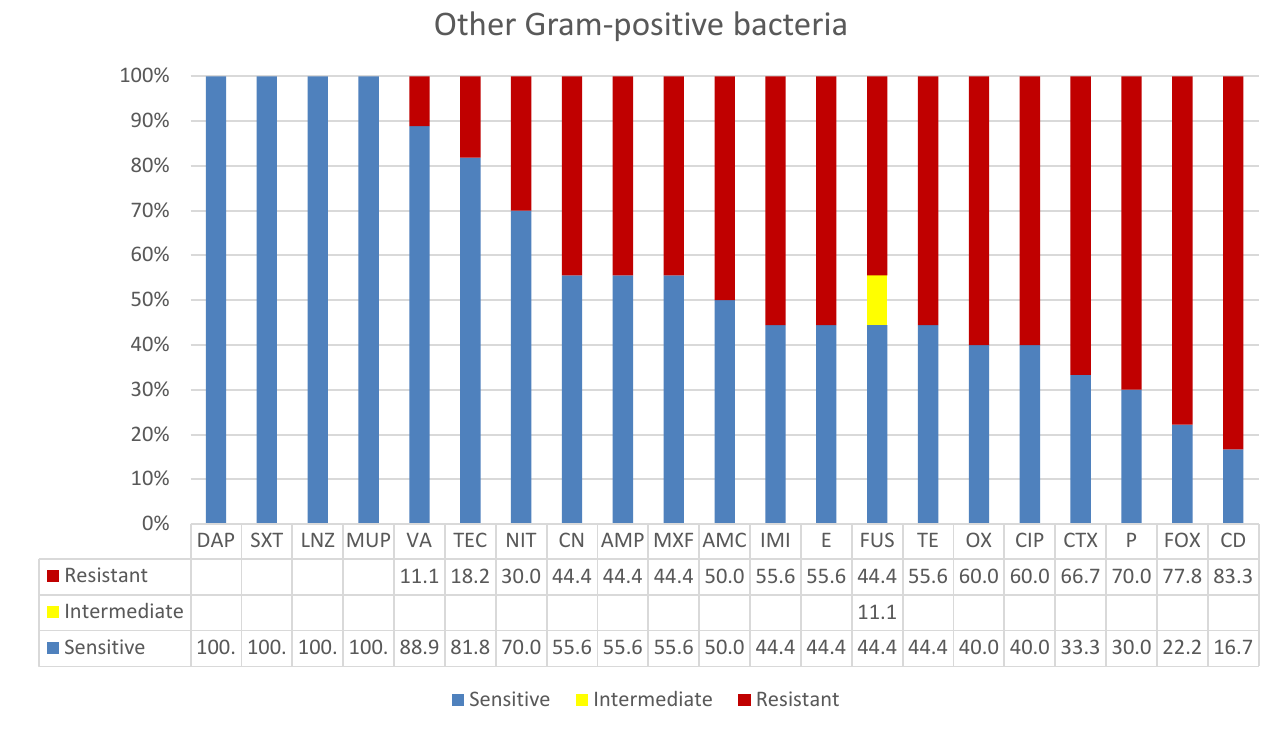
Figure 4. Antimicrobial sensitivity patterns of “Other Gram-positive bacteria” isolates to 21 antibiotics. Abbreviations (in the order in which they appear in the figure): DAP daptomycin, SXT trimethoprim*/sulfamethoxazole, LNZ linezolid, MUP mupirocin, VA vancomycin, TEC teicoplanin, NIT nitrofuran, CN gentamicin, AMP ampicillin, MXF moxifloxacin, AMC ampicillin*/sulbactam, IMI imipenem, E erythromycin, FUS fusidic acid, TE tetracycline, OX oxacillin, CIP ciprofloxacin, CTX cefotaxime, P penicillin, FOX cefoxitin, CD clindamycin.